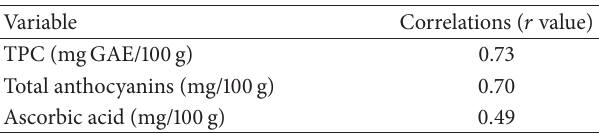
Table 4: Pearson correlation between the value of TPC, total anthocyanins, and vitamin C and antioxidant activity.